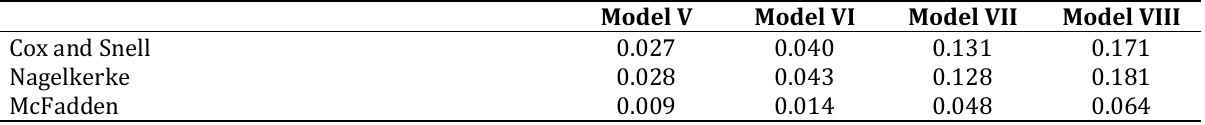
Table 6: Pseudo R- squares of Models V, VI, VII and